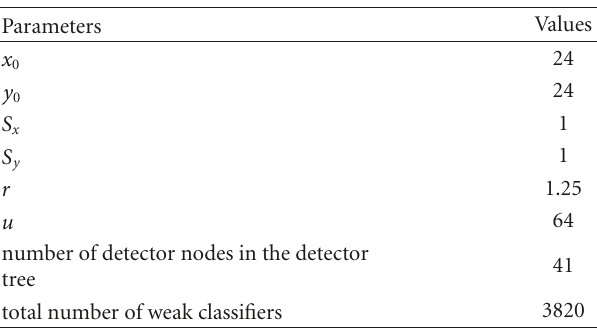
Table 3: Parameter settings for